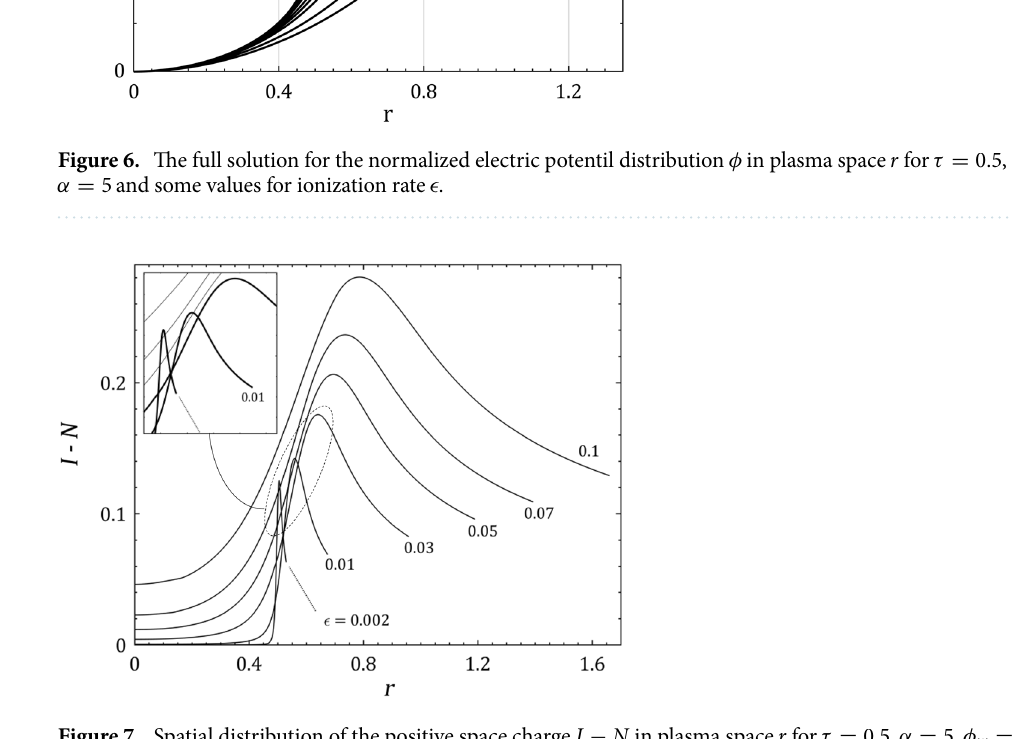
N in plasma space r for τ −